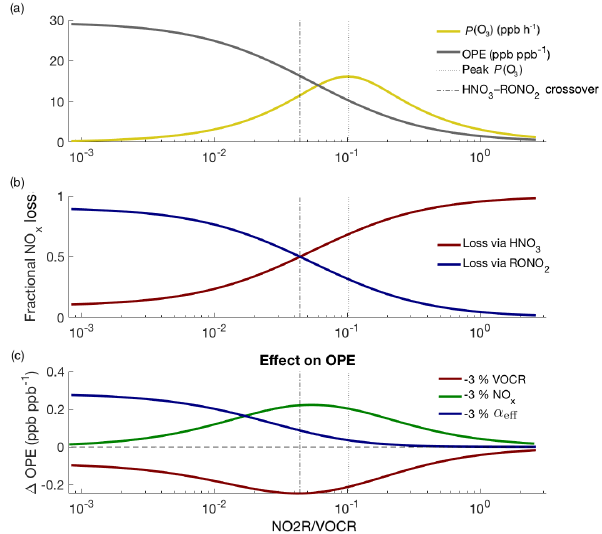
Figure 6. Theoretical picture of NO x and O 3 chemistry, calcu- lated using variable NO x concentrations and fixed VOCR, P( HO x ) , and α eff . Panel (a) shows how P( O 3 ) and OPE change as NO x changes; panel (b) shows how the fractional NO x loss changes as NO2R / VOCR decreases; panel (c) shows that changes to NO x and VOCR have their greatest effect on OPE not when P( O 3 ) is at a maximum, but at the crossover point between the RONO 2 - dominated and HNO 3 -dominated